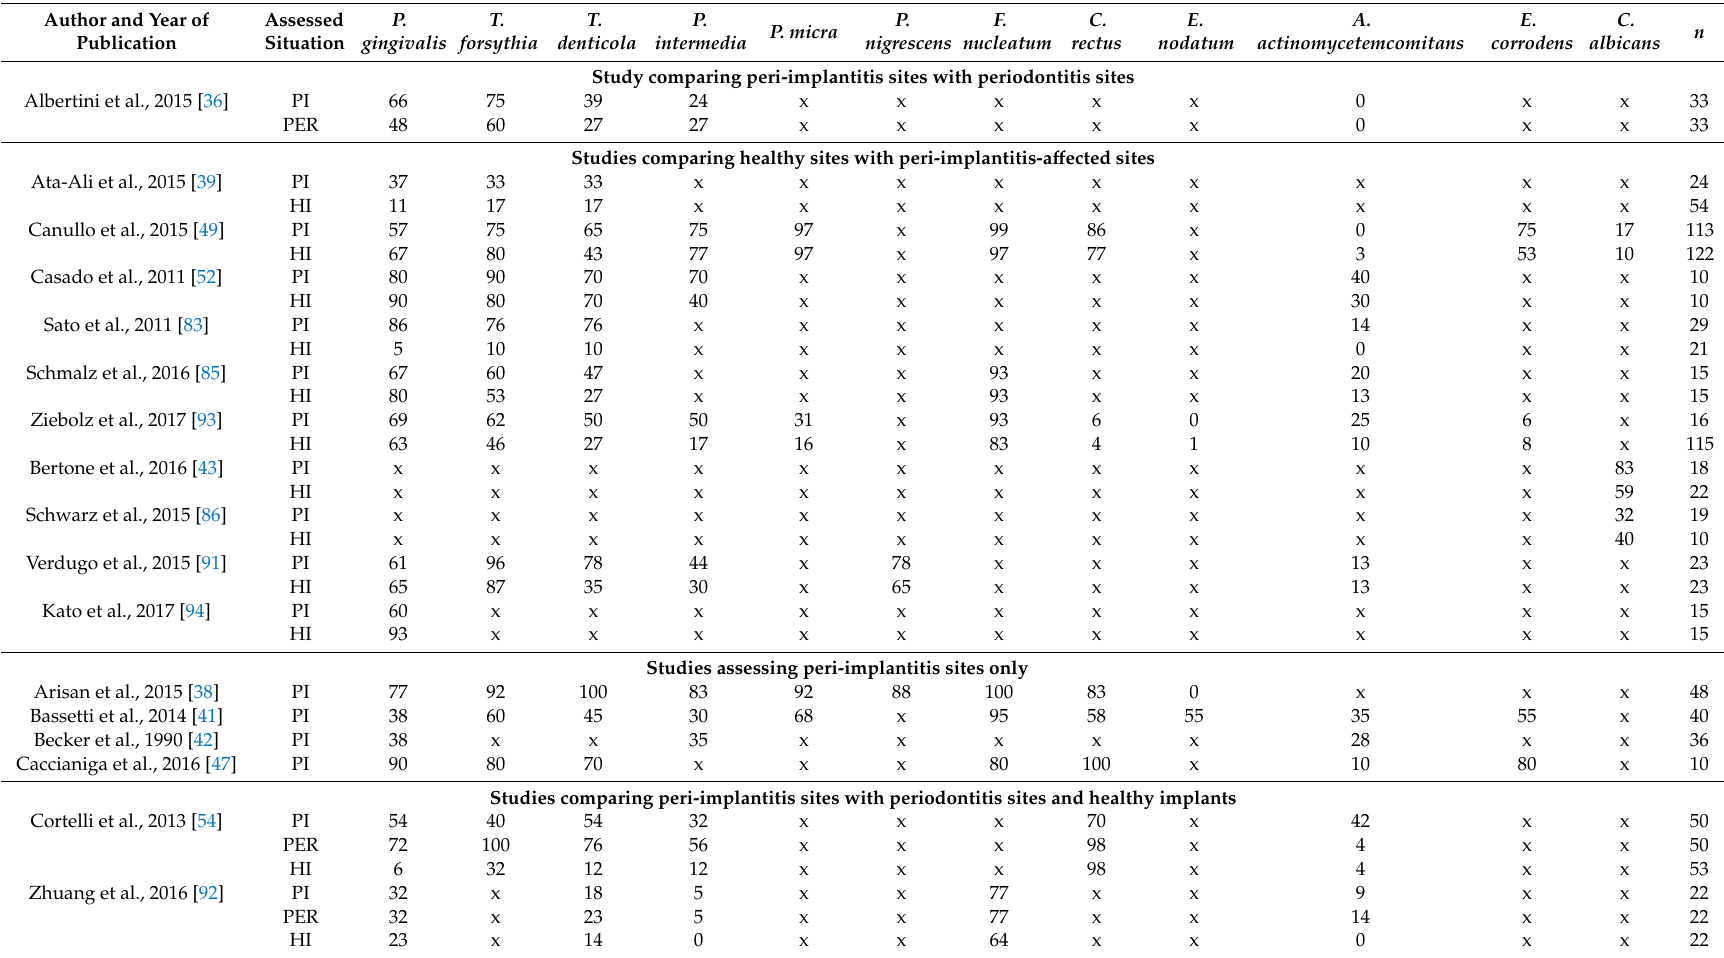
Table 3. Studies assessing di ff erent species using PCR-based